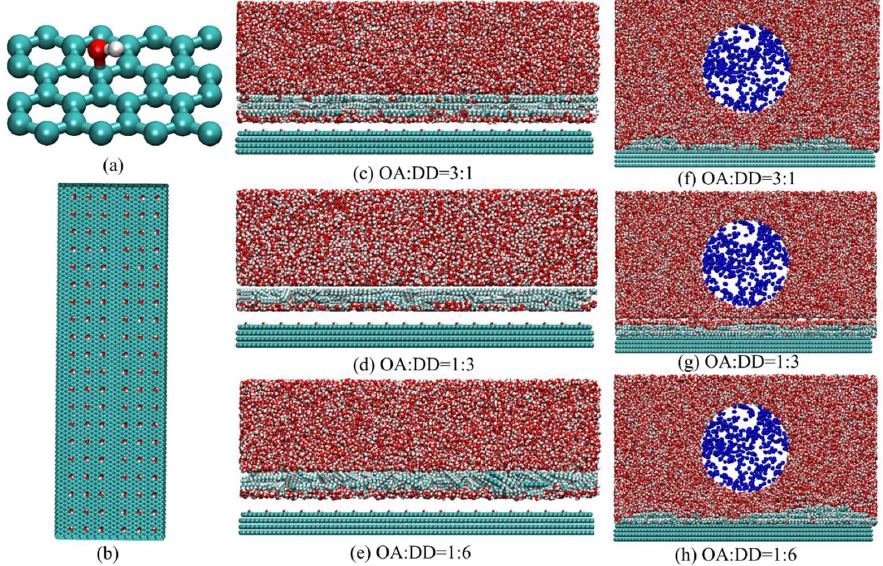
Figure 2. Initial configuration of ( a ) LRC surface repeating unit, ( b ) LRC model (top view), ( c – e ) oil film adsorption simulation systems, and ( f – h ) bubble adsorption on oil film surface simulation sys- tems. Red atoms are oxygen atoms, green atoms are carbon atoms, white atoms are hydrogen atoms, and blue atoms are nitrogen atoms.